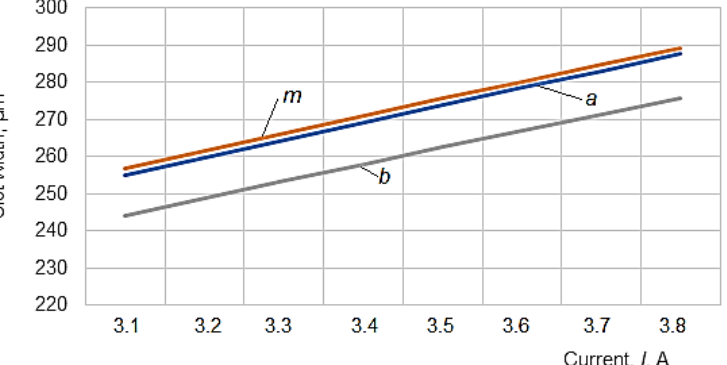
Figure 6. Influence of current I on the widths of the slots when the wire electrode enters the test sample ( a ), in the middle of the thickness of the test sample ( m ), and at the exit of the wire electrode in the test sample ( b ) ( H = 20 mm, T on = 12 µs, T off = 30 µs, F = 10.54 N, v = 1500 mm/min, U = 160 V).